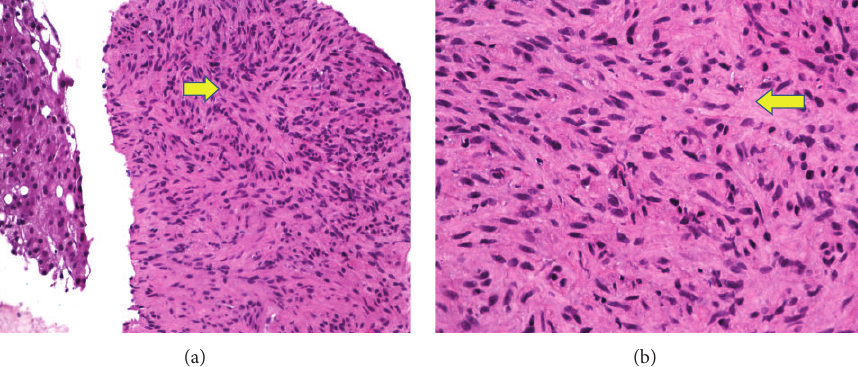
Figure 3: Histopathology of the hepatic mass. (a) Spindle shaped cells distributed in a collagenous stroma. (b) Spindle cells proliferation in interlacing pattern.